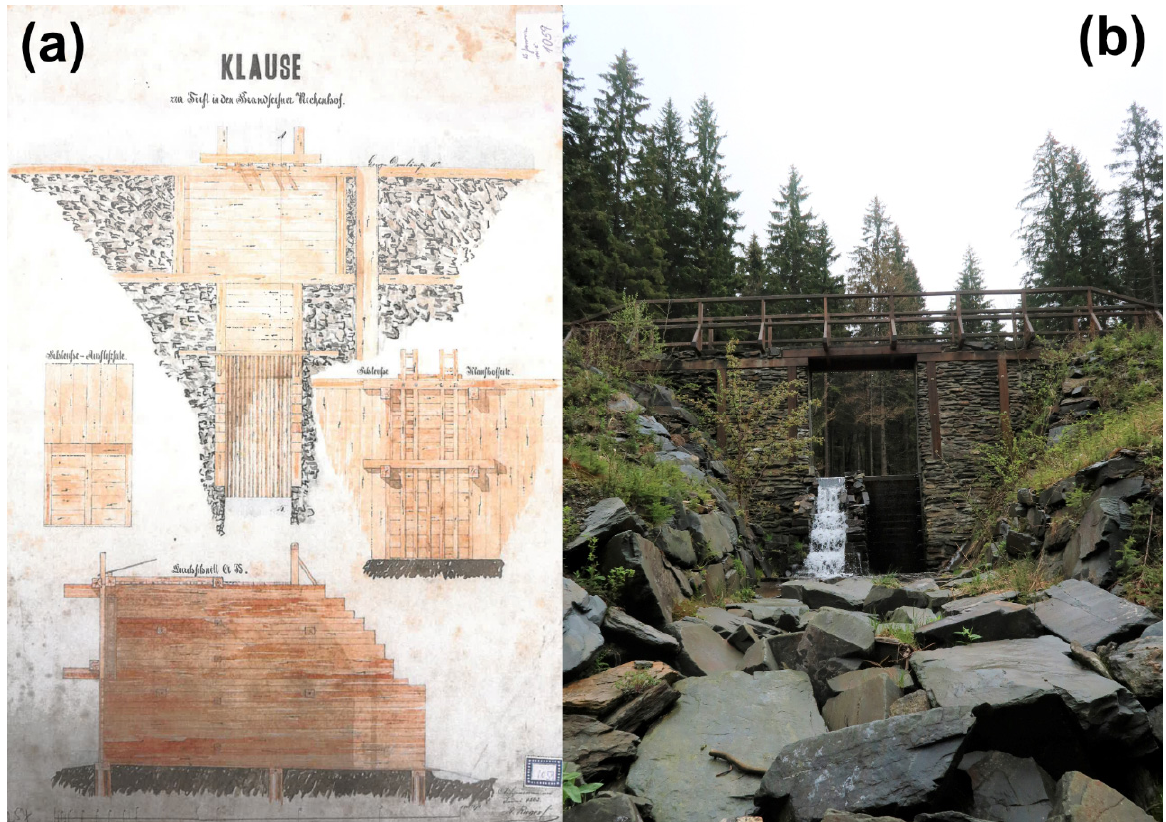
Figure 11. The splash dam on Splavský creek: ( a ) a historical technical drawing from 1863, and ( b ) the current state after a 2014 reconstruction.